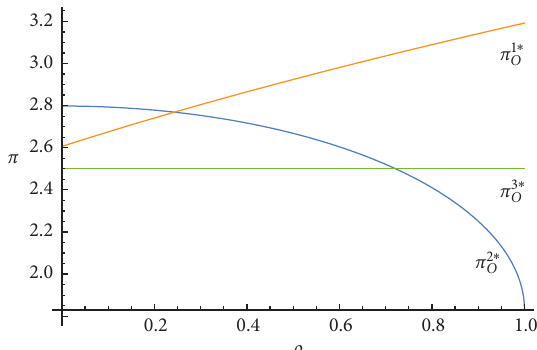
Figure 3: Effects of ρ on the maximum expected profit of the e- commerce platform.